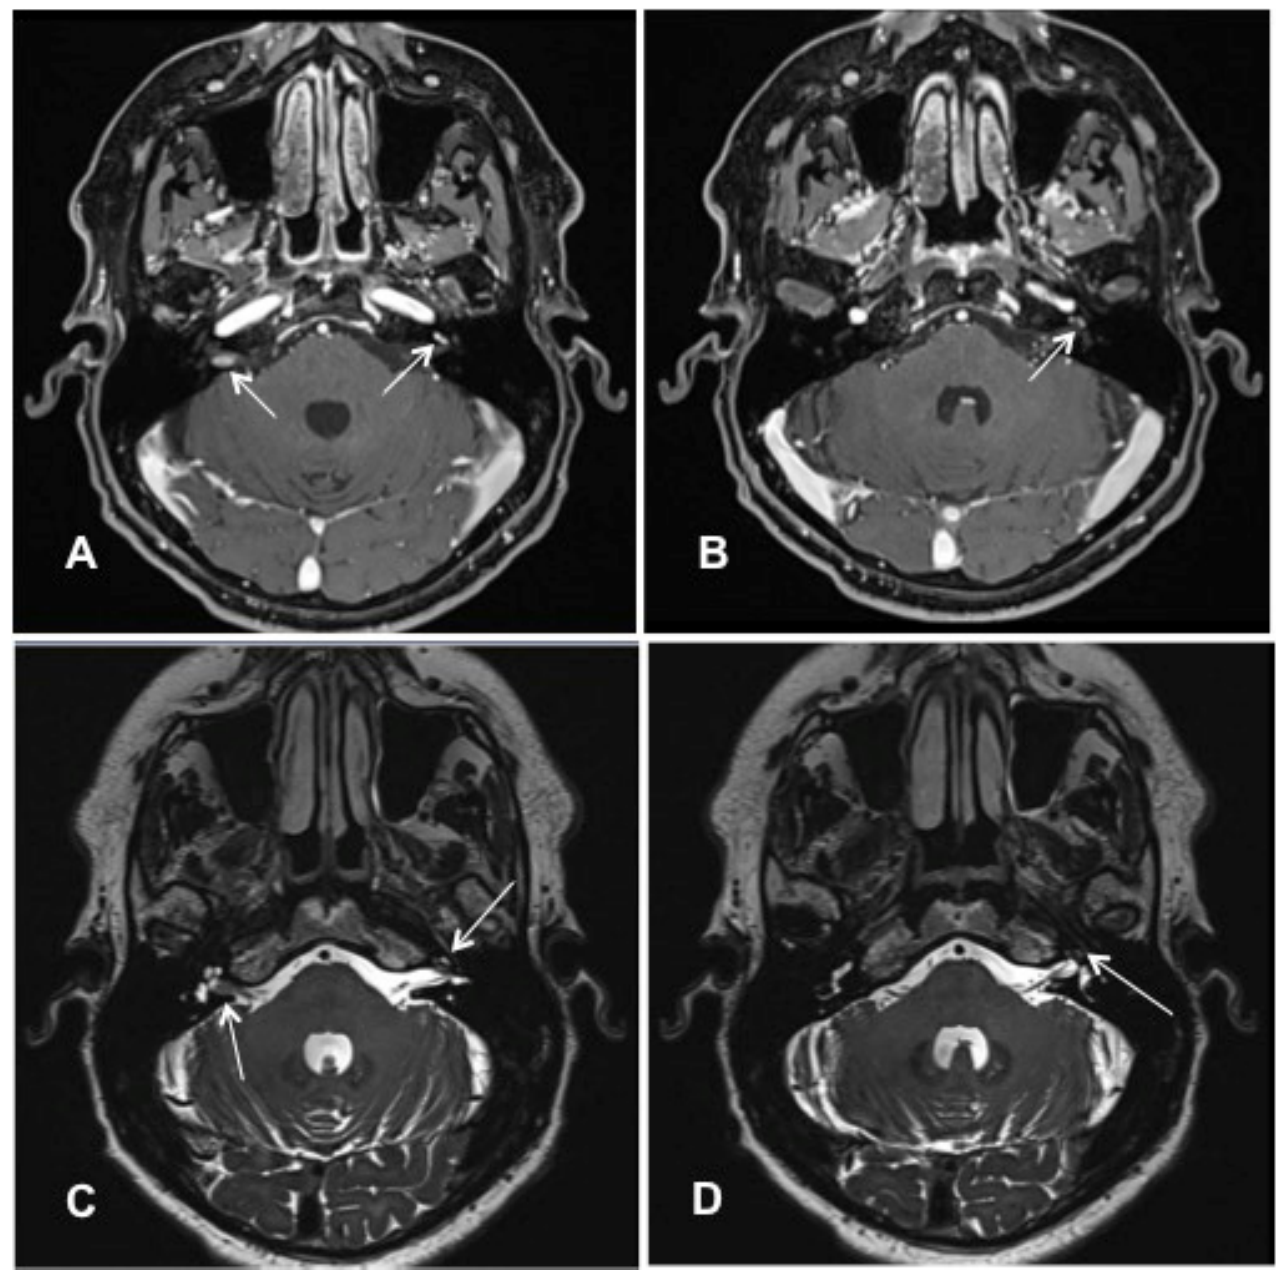
Figure 4. Case #4: MR images visualizing bilateral ILS (right side: intrameatal location, left side: intracochlear location). ( A , B ): T1 weighted VIBE 3D with fat saturation prepulse after the intravenous administration of gadolinium. ( A ) White arrows: intrameatal VS on the right side and ILS on the left side. ( B ) The white arrow points to the intracochlear schwannoma on the left side (middle turn); ( C , D ): T2 weighted SPACE sequences. ( C ) White arrows point to the intrameatal VS on the right and the ILS on the left. ( D ) The white arrow points at the ILS on the left side (middle turn).